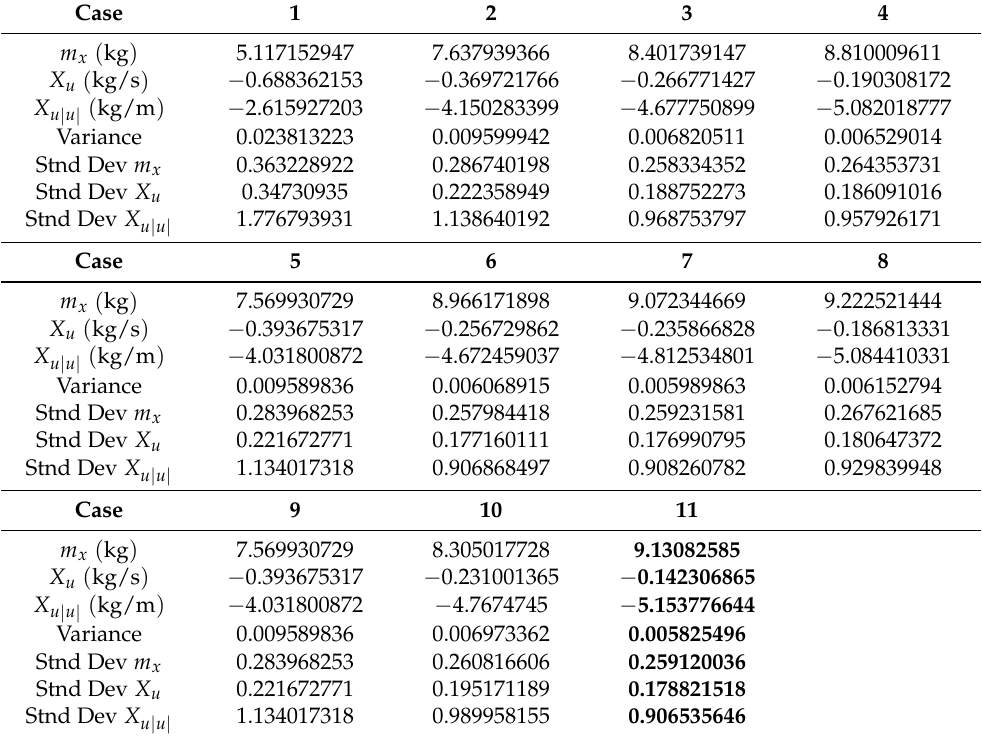
Table A2. Results of the estimation of hydrodynamic parameters for the positive motion in b x with 150